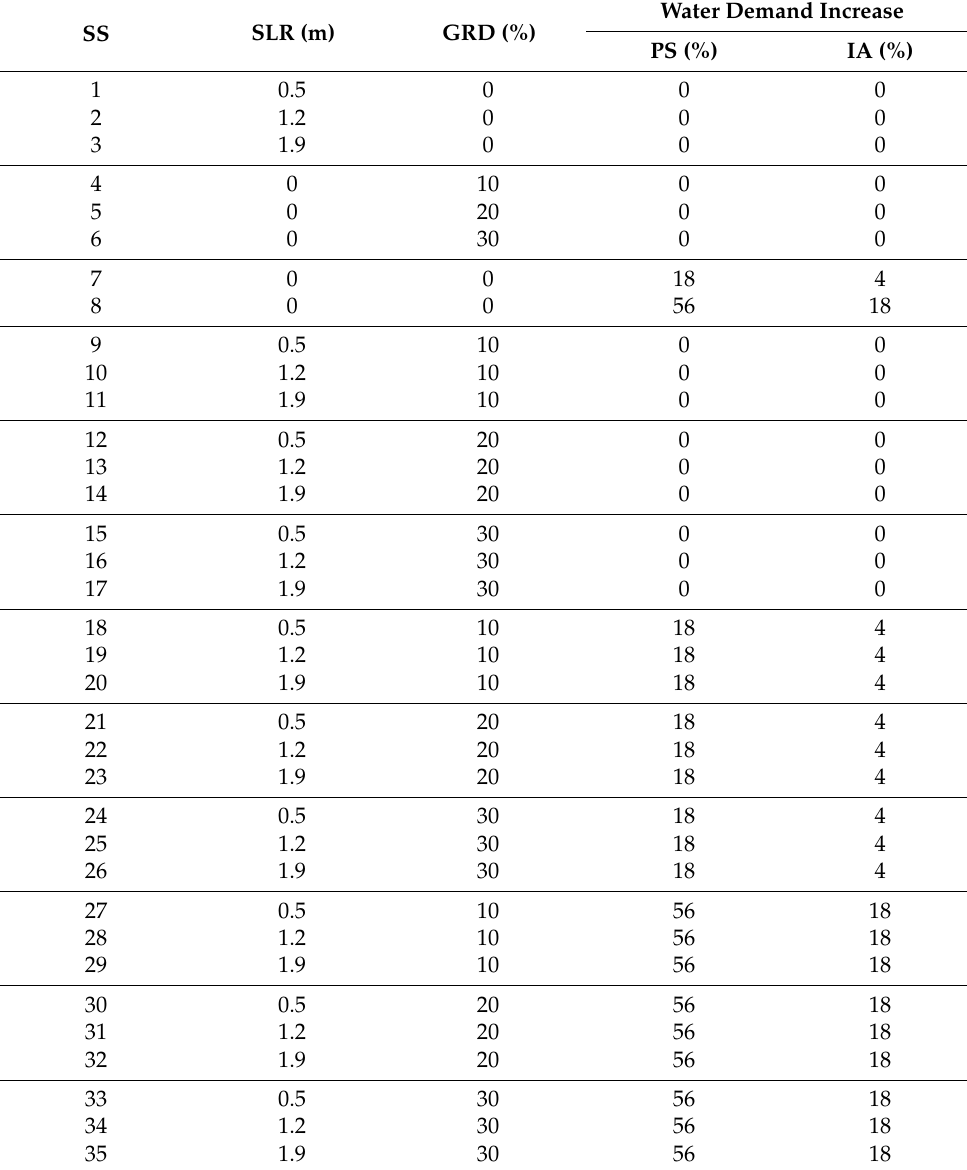
Table 3. Transient simulations combining climate change impacts expected in 2100 (SS: simulated scenario; SLR: sea-level rise; GRD: groundwater recharge decrease; PS: public supply; IA: irrigation